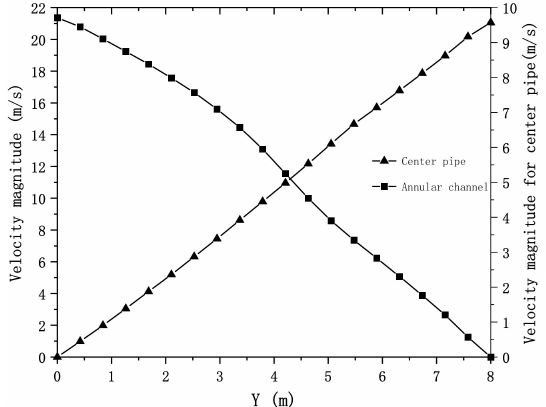
Figure 5. Velocity variation along the axial direction in the annular channel and the center pipe.